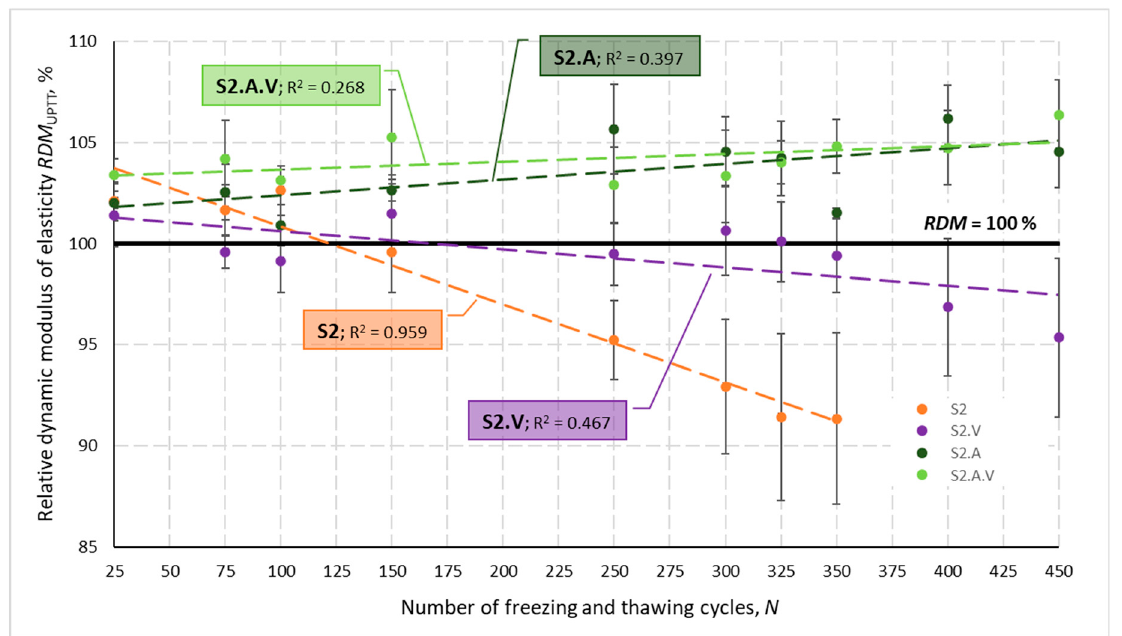
Figure 16. Mean relative dynamic modulus of elasticity for S2, S2.V, S2.A and S2.A.V concretes after N cycles of freezing and thawing.